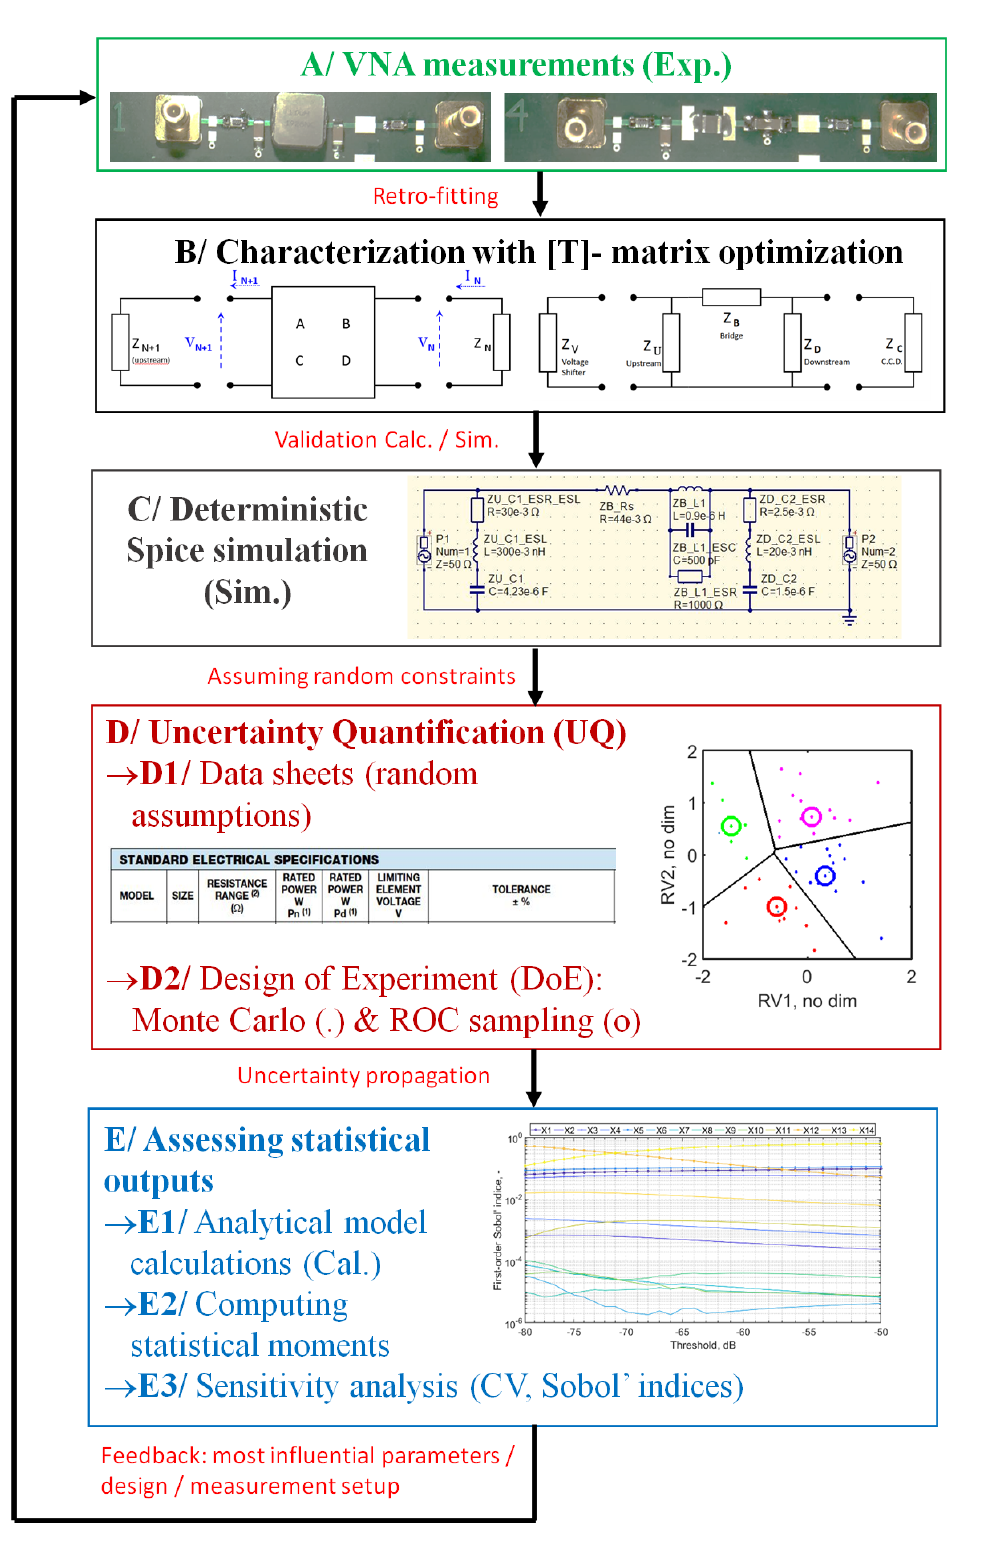
Figure 7. Global methodology flowchart, from steps ( A – E ). A : VNA measurements (Exp.) of S 21 parameter (Test Board, see results in Figure 6). ( B ): Retro-fitting of analytical reduced mod- els (Calc.). ( C ): Spice simulation deterministic model (Sim.). ( D ): UQ through MC and ROC. ( E ): Statistical